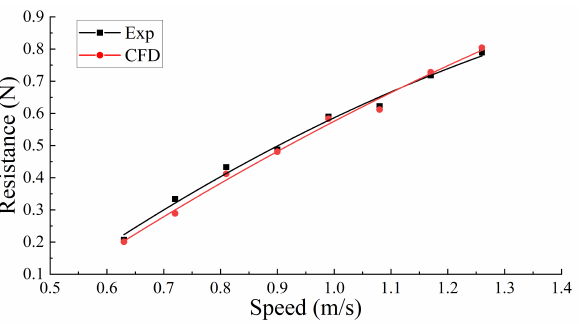
Figure 19. ( a ) 3D SUBOFF model. ( b ) Experiment platform calibration based on the 1/8 SUBOFF model.